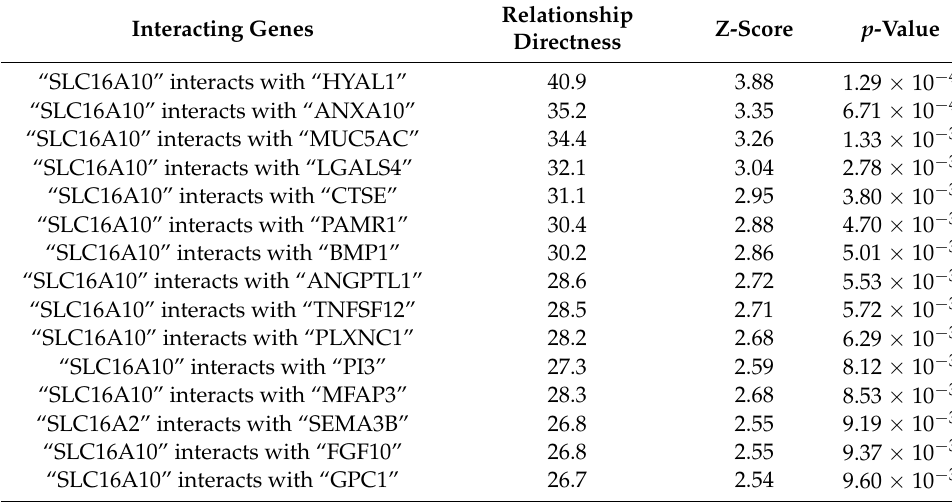
Table 4. The strongest interactions found between differentially expressed MCT and ECM genes within the silenced network. Values from the matrix S describing the directness of the relationship between node pairs are presented alongside a z-score describing the position of this value in the whole network and the associated p -value of this position. All interactions presented below are statistically